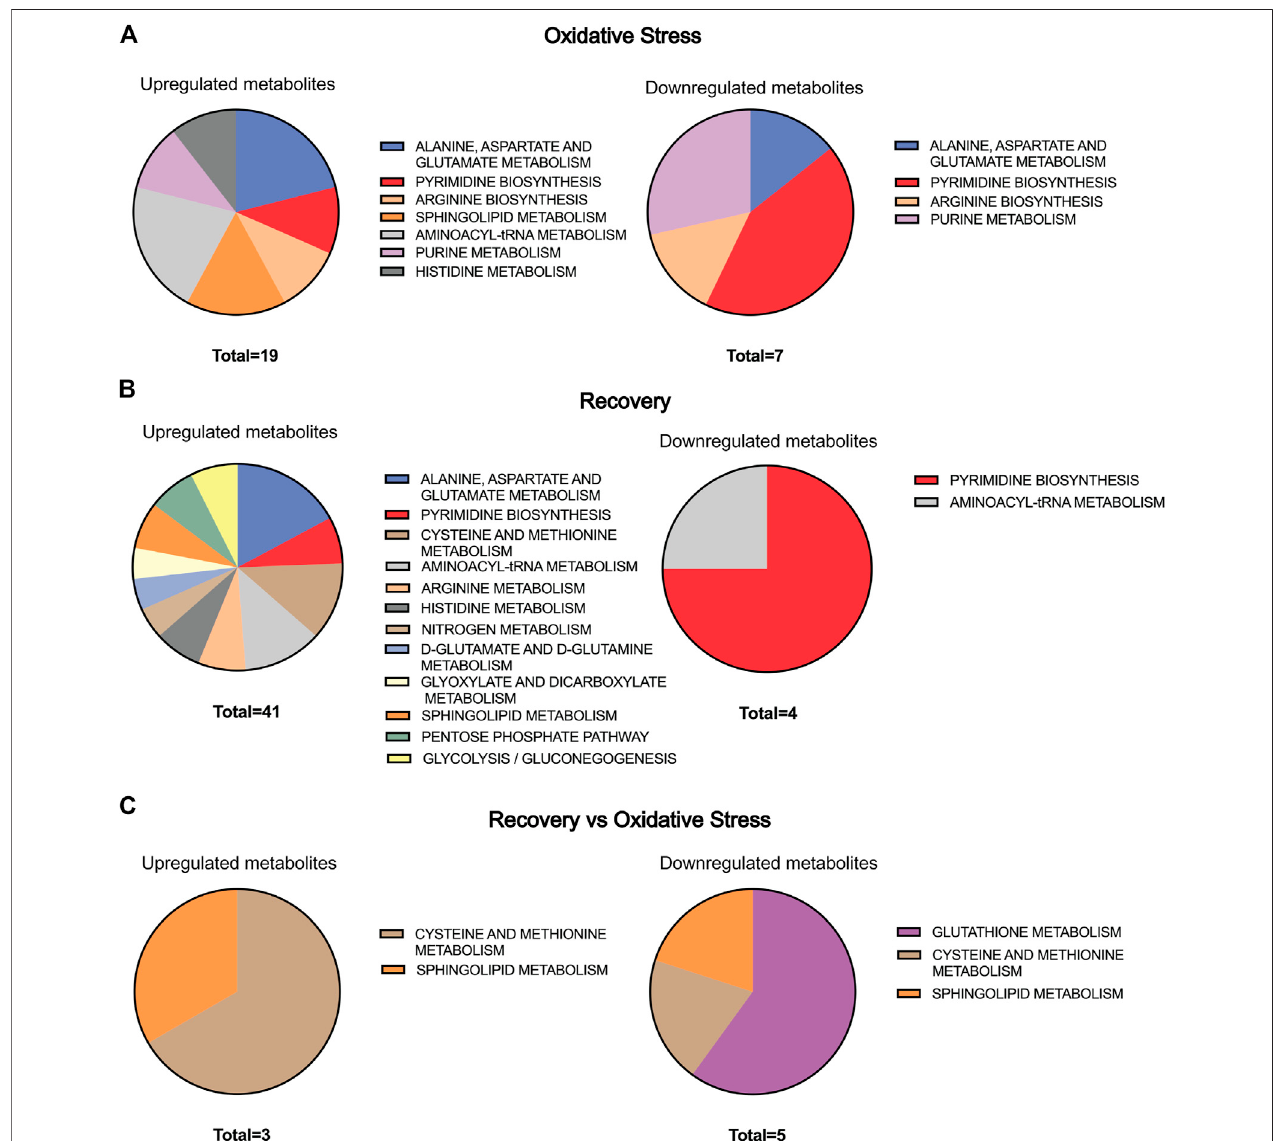
FIGURE 3 | Pie chart representation of the statistically signi fi cant metabolic pathway present in Table 3 for (A) oxidative stress, (B) recovery, and (C) recovery vs. oxidative stress. The size of the pie chart is represented by the number of up- and downregulated metabolites in each group.